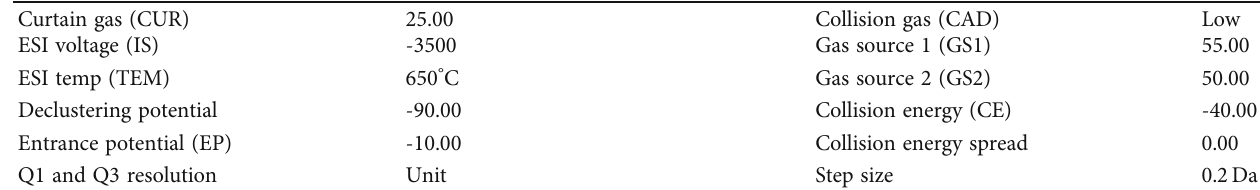
Table 2: Mass spectrometry instrumental parameters during resolution of polar